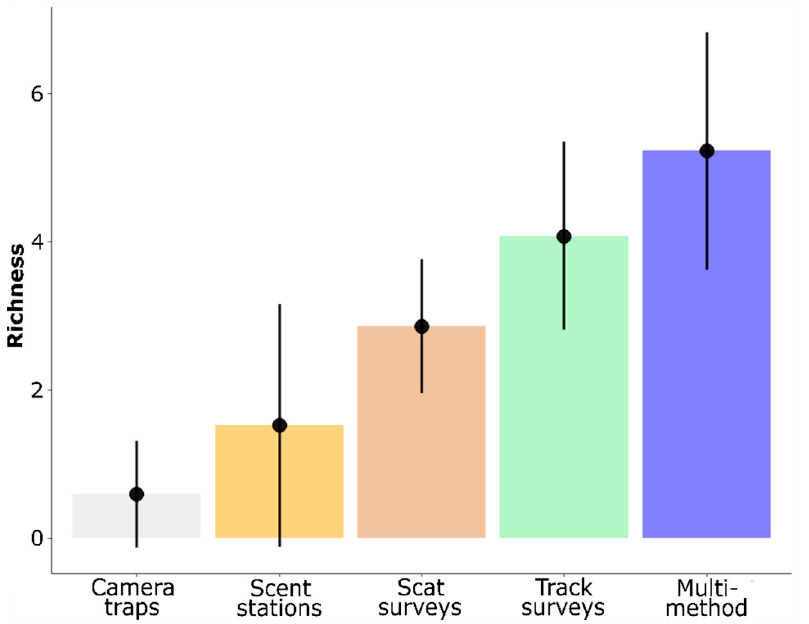
Figure 2. Mean (± SD) species richness of Iberian mammals observed from four survey methods and the multi-method survey in the lower Guadiamar basin ( n = 96 per method, i.e., 24 sampling units × 4 sessions).